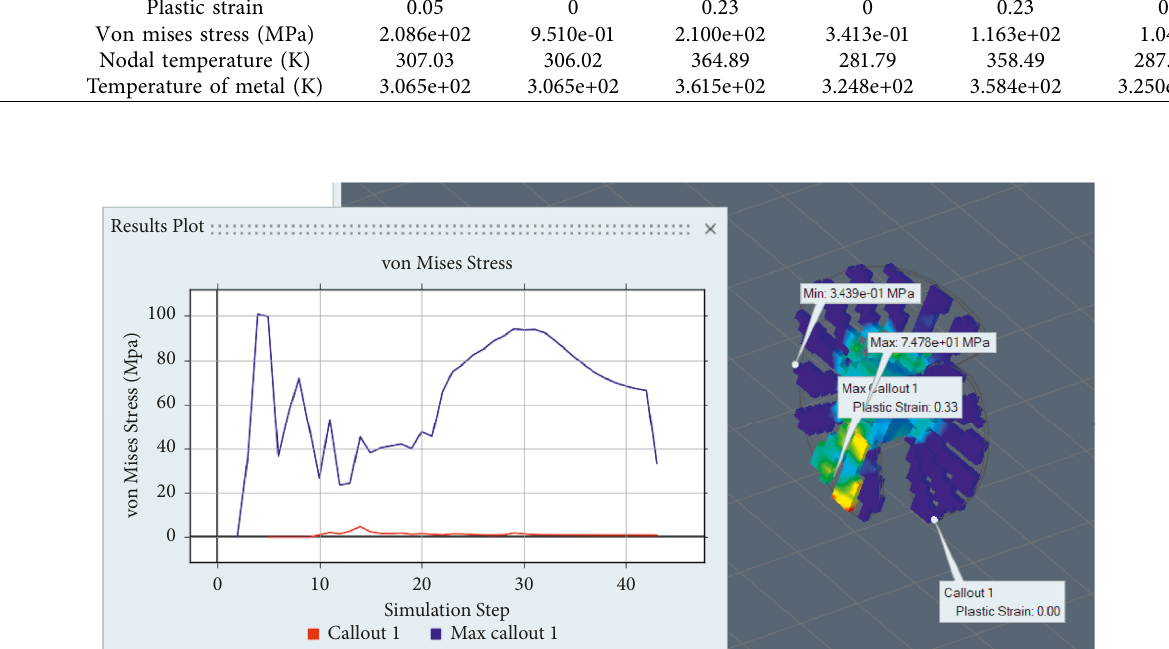
Figure 4: Von mises stress various callout positions and a graph representing the von mises vs simulation step for Rank 1.